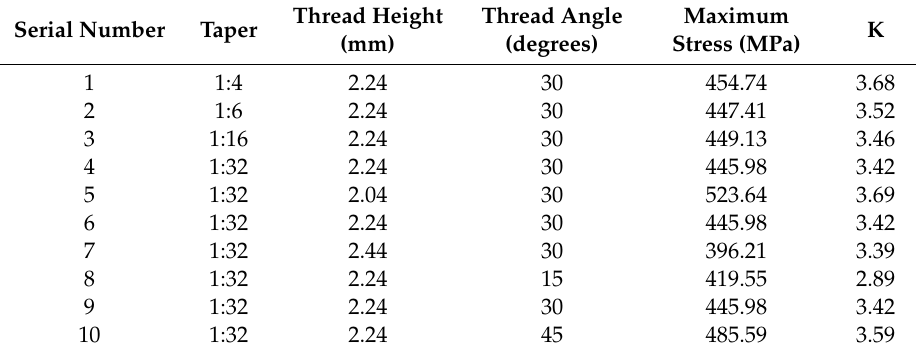
Table 1. Stress states under di ff erent structural parameters.